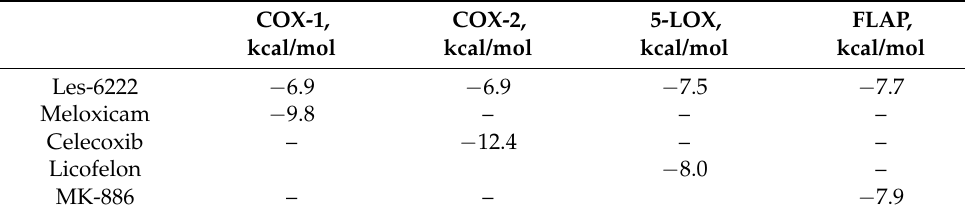
Table 3. The binding energy of Les-6222 complexes and comparison drugs with biotargets.